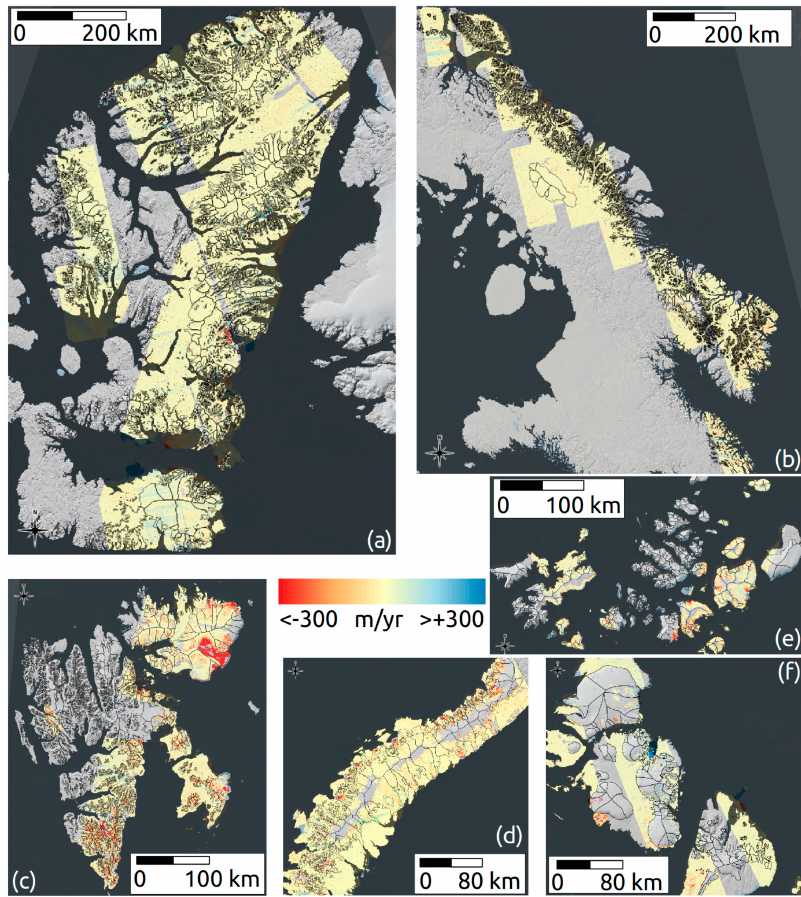
Figure 4. Difference map of the ice velocity results of Figure 2 (1994–2011) and 3 (2015–2017). ( a ) the Canadian Arctic North, ( b ) the Canadian Arctic South, ( c ) the Svalbard Archipelago, ( d ) Novaya Zemlya, ( e ) Franz-Josef Land and ( f ) Severnaya Zemlya. Remote Sens. 2017 , 9 , 947